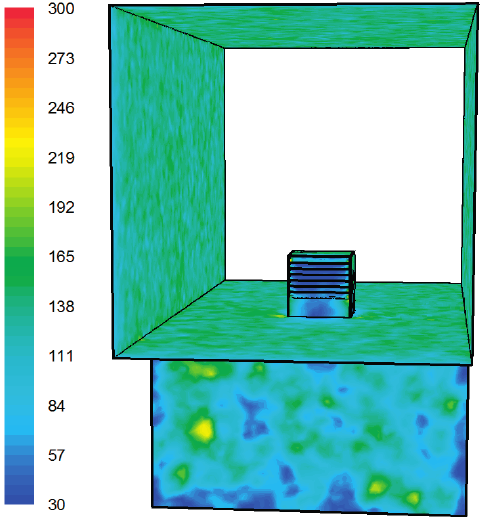
Figure 6. Contour of wall y-plus